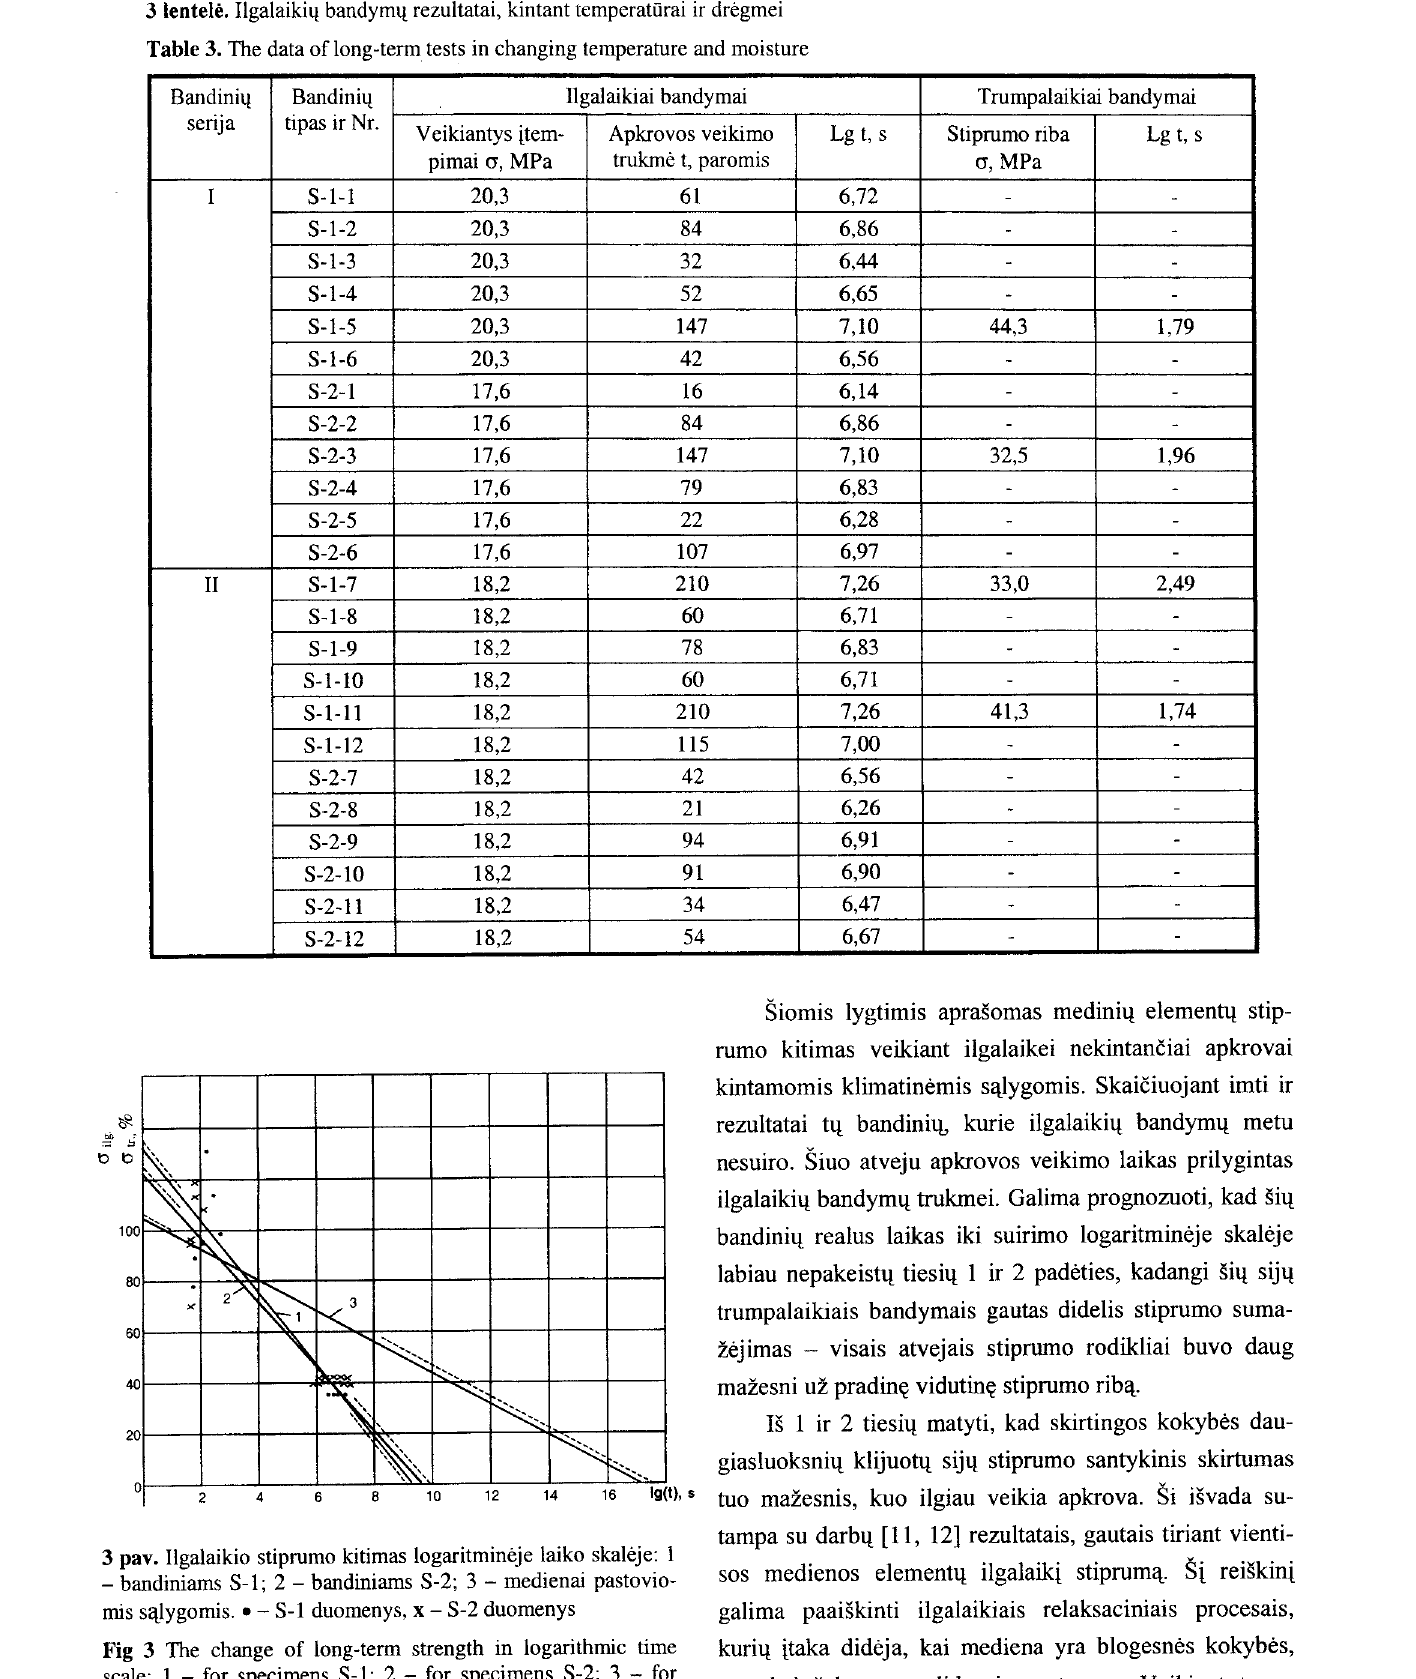
- bandiniams S-1; 2- bandiniams S-2; 3- medienai pastovio mis Sillygomis. •- S-1 duomenys, x- S-2 duomenys Fig 3 The change of long-term strength in logarithmic time scale: 1 - for specimens S-1; 2 - for specimens S-2; 3 - for timber under constant conditions. • - data of specimens S-1, x - data of specimens